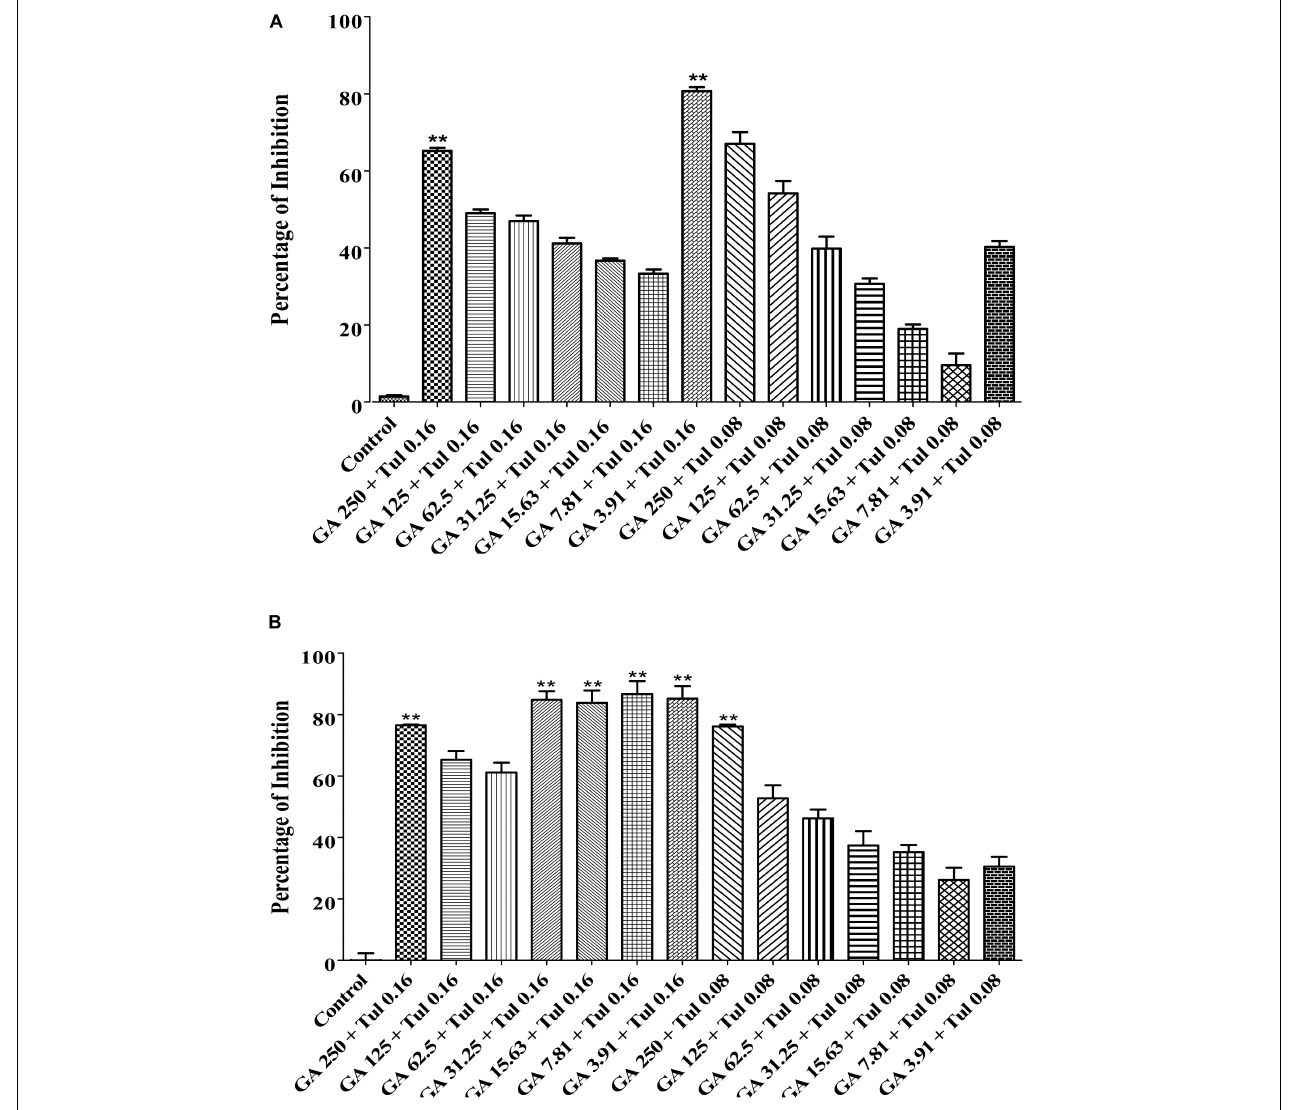
FIGURE 2 | Antimicrobial activity of the combination of tulathromycin and gallic acid against M. haemolytica (A) and P. multocida (B) . The concentration of tulathromycin was 0.08 and 0.16 µ g/mL, respectively, and the concentration of gallic acid was from 3.91 to 250 µ g/mL. Bacterial cell culture medium, BHIB, was used as a negative control. One way ANOVA t -test was used for statistical significance. ∗ P -value < 0.05, ∗∗ P -value < 0.01, and ∗∗∗ P -value < 0.001 are shown. Correlation coefficient ( r ) was calculated using Pearson’s correlation method.